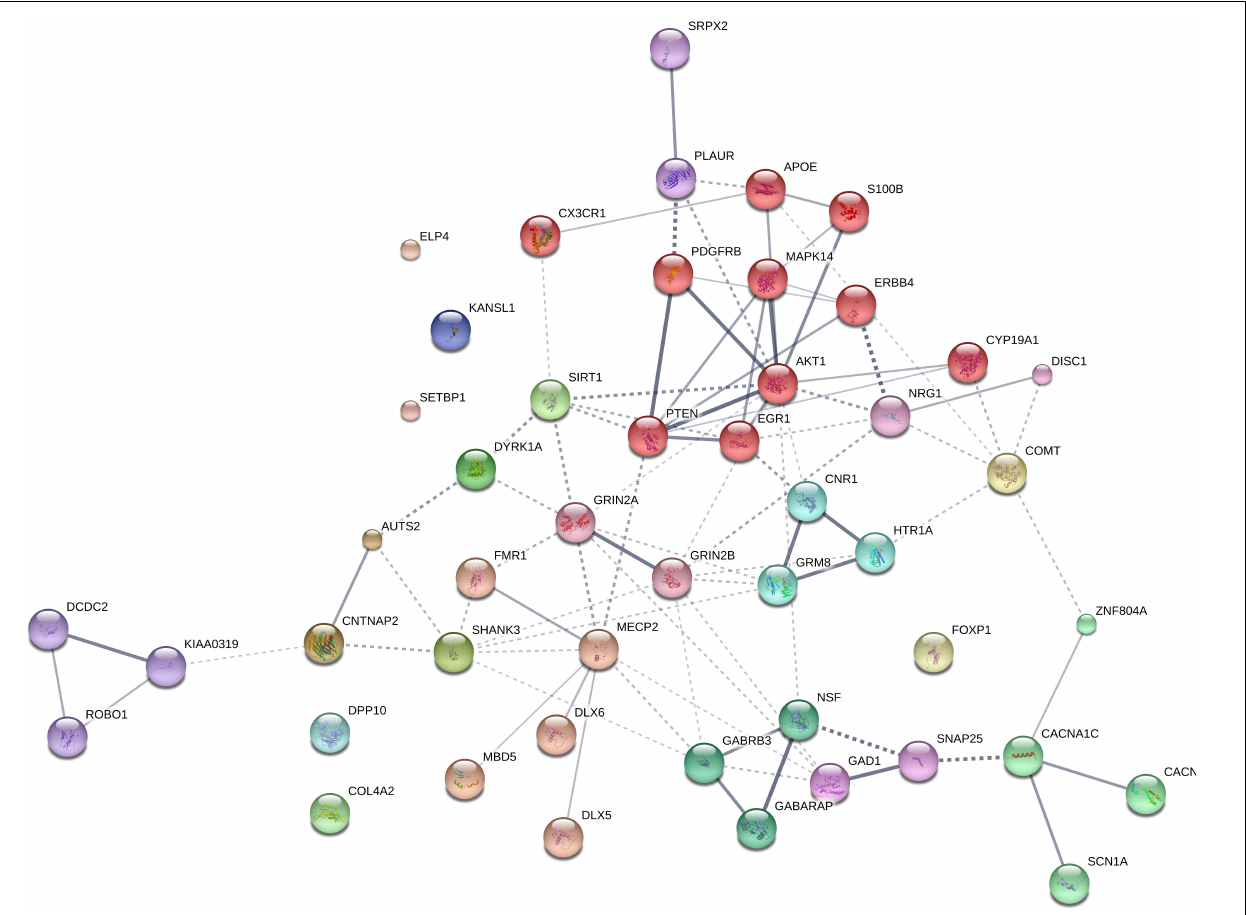
FIGURE 1 | Protein interaction network. The diagram shows the network of known and predicted interactions among proteins encoded by genes proposed as candidates for the language oscillogenome ( Table 1 ). The network was drawn with String (version 10.0; Szklarczyk et al., 2015) license-free software (string-db.org/), using the confidence visualization. It contains 48 nodes and 86 edges, with an average node degree of 3.58 and an average local clustering coefficient of 0.384. Colored nodes symbolize proteins included in the query (small nodes are for proteins with unknown 3D structure, while large nodes are for those with known structures). The line thickness of the edges indicates the strength of data support. The medium confidence value was 0.0400 [a 40% probability that a predicted link exists between two enzymes in the same metabolic map in the KEGG database: (genome.jp/kegg/pathway.html)]. Each protein cluster is represented with a different color of the nodes. Inter-cluster edges are represented by dashed-lines. As discussed in the main text, the MCL clustering algorithm was used, selecting the inflation parameter of 2. The input to the algorithm is the distance matrix obtained from the String global scores. The inflation parameter is indirectly related to the precision of the clustering (the higher the inflation, the more clusters one obtains). The diagram only represents the potential connectivity between the involved proteins, which has to be mapped onto particular biochemical networks, signaling pathways, cellular properties, aspects of neuronal function, or cell-types of interest (see the main text for details and Table 2 for a GO